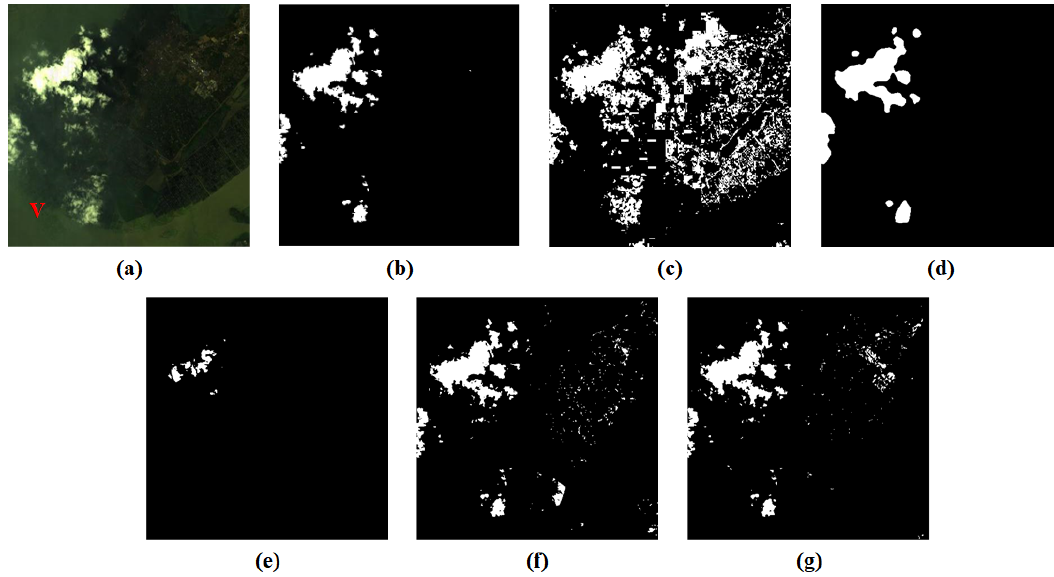
Figure 8. Cloud detection maps of the compared methods: ( a ) Input images labeled V from the GF-5 dataset, ( b ) proposed, ( c ) K-means, ( d ) PRS, ( e ) PCANet, ( f ) SVM, and ( g ) SL.